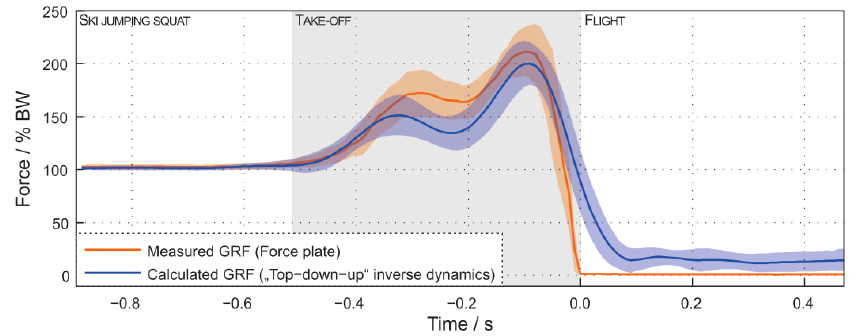
Figure 16. Comparison of the vertical GRF calculated by the IMUs and the one directly measured by the force platform [72].